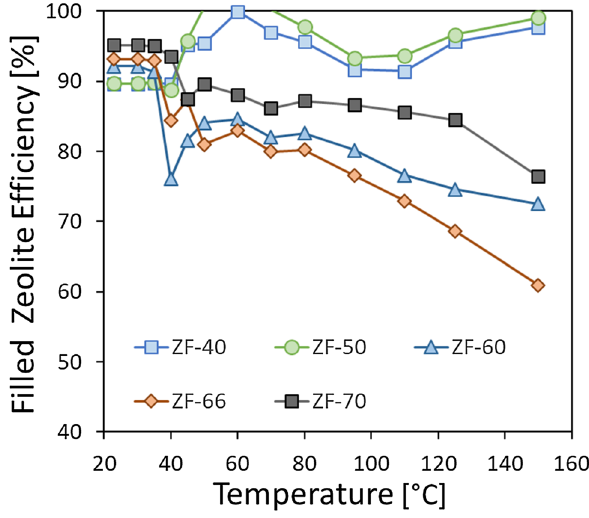
Fig. 8 Normalized Water adsorption isobars at 11 mbar for filled and unfilled zeolite foams